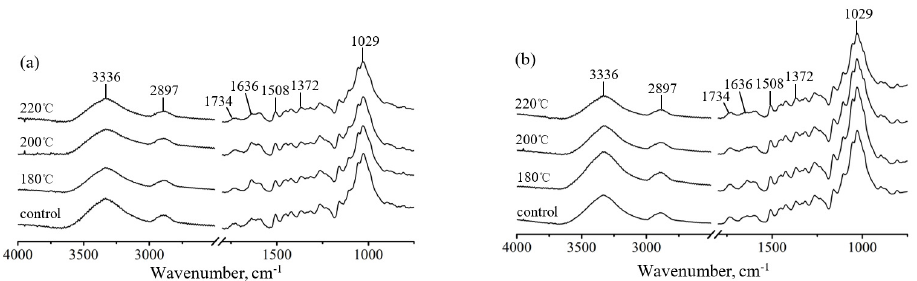
Figure 7. FTIR spectra of tracheid cell wall of EW ( a ) and LW ( b ) before and after vacuum heat treatment.